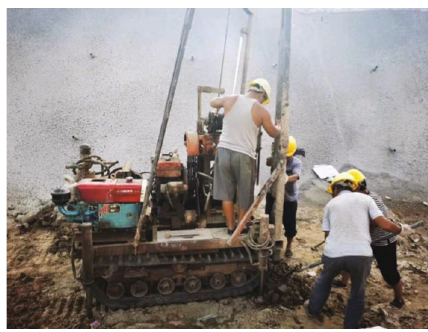
Figure 1: Plane layout of static cone penetration test points.